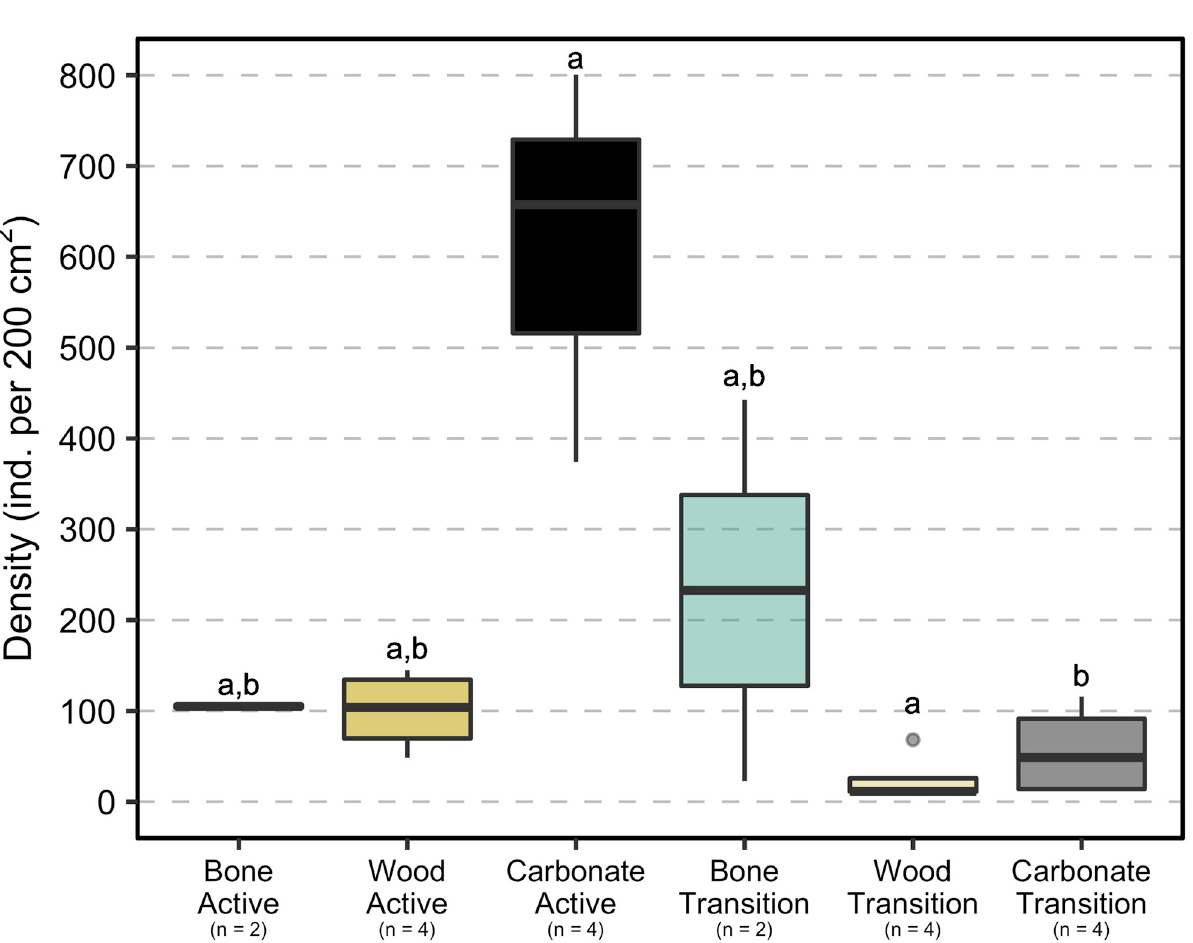
Fig 4. Density of macrofaunal colonizers on the experimental substrates. Densities (individuals per 200 cm 2 ) of the macrofaunal invertebrate community on experimental bones, wood, and carbonate rocks deployed for 7.4 years (2010–2017) at active (n = 2 bones, 4 woods, and 4 carbonate rocks) and transition (n = 2 bones, 4 woods, and 4 carbonate rocks) sites at Mound 12. Boxplots visualize five summary statistics: the mean, two hinges (the 25 th and 75 th percentiles), and two whiskers (extend from the hinge to the largest/smallest value at 1.5x the inter-quartile range), as well as outlying points individually. Data points are available in S1